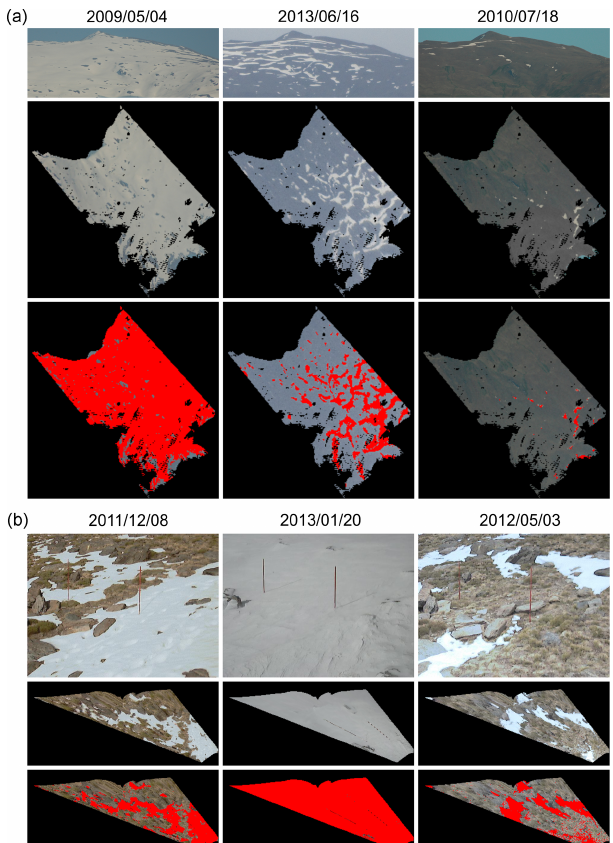
Figure 5. Selected examples of the images, georeferenced pro- jections and snow maps (red pixels) from the time-lapse cameras (a) C1 (2km 2 ) and (b) C2 (30m × 30m) in the Guadalfeo Network that illustrate the patchy pattern of the spatial distribution of the snow in the study